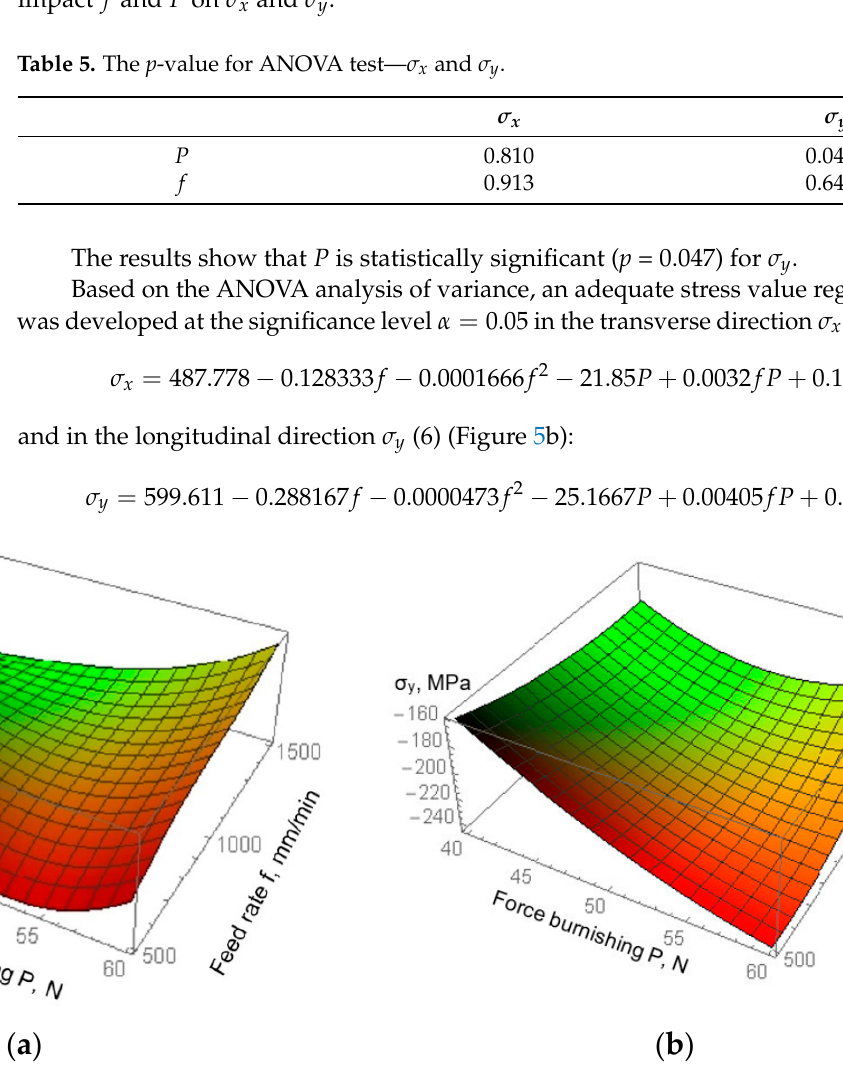
Figure 5. Plots of the regression functions of residual stresses ( a ) in the transverse direction σ x , ( b ) in the longitudinal direction σ y .